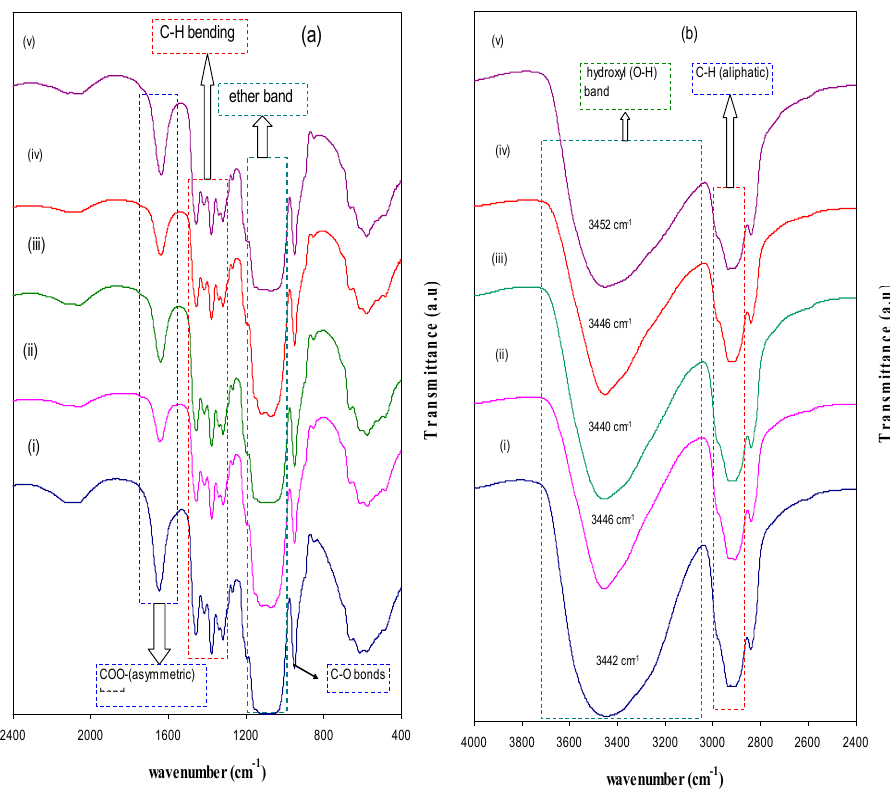
Figure 13. FTIR spectra of (i) MCPN0 (pure MC), (ii) MCPN1, (iii) MCPN2, (iv) MCPN3, and MCPN4 in the region ( a ) 400 to 2400 cm − 1 and ( b ) 2400 to 4000 cm − 1